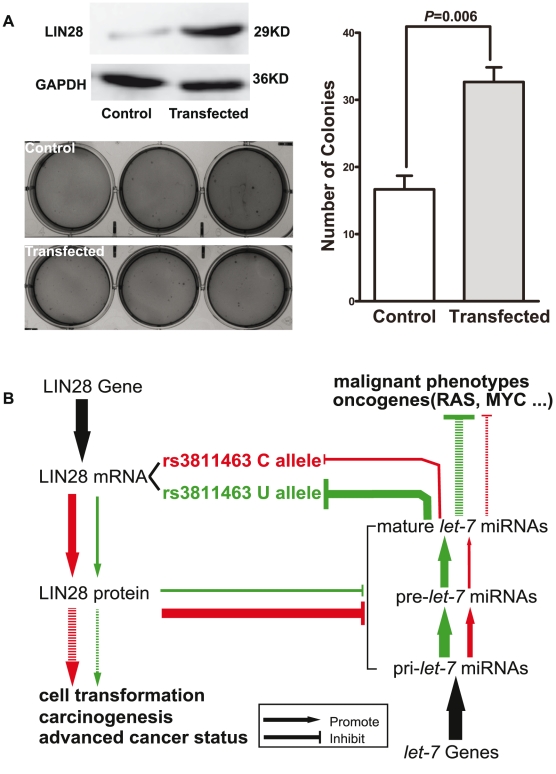
LIN28 transforms MCF 10A cells.A, LIN28 transforms MCF 10A cells. The upper left panel shows the Western blot analysis of protein extracted from the control MCF 10A or the LIN28-overexpressing MCF 10A cells. The bottom left and right panels show the number of colonies formed in the soft agar assay. Data shown represent mean colony numbers with error bars showing standard errors. MCF 10A cells stably overexpressing LIN28 formed significantly more colonies than the MCF 10A cells infected with control viral supernatant (P = 0.006). B, schematic representation of the biological model. In this model, LIN28 harboring the rs3811463-T allele was set as the baseline condition (green loop). Replacement of the T allele by the C allele at rs3811463 weaken the suppression of the LIN28 mRNA by let-7, leading to overexpression of LIN28 protein and, in turn, lower levels of let-7. Both high levels of LIN28 and low levels of let-7 are associated with carcinogenesis, as indicated in the Introduction section.